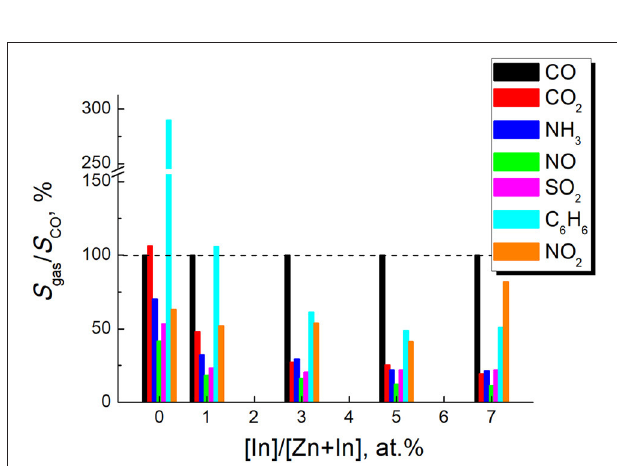
FIGURE 11 | Sensor signals to different tested gases divided by the sensor signal to 5 ppm CO for the samples of zinc oxide modified by different amounts of In 2 O 3 . Sensor signals were measured at temperature 450 ◦ C. The test gases and concentrations were: CO 2 -1%, NH 3 -5 ppm, SO 2 -5 ppm, NO − 5 ppm, C 6 H 6 -5 ppm, NO 2 -5 ppm.